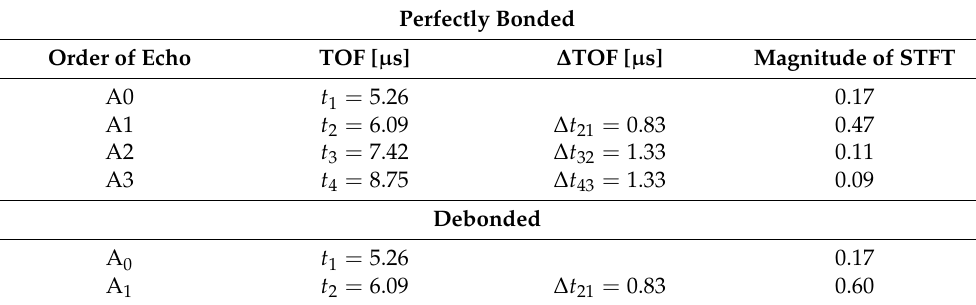
Table 4. Estimated properties of the signal from a perfectly bonded and debonded coating layer of epoxy